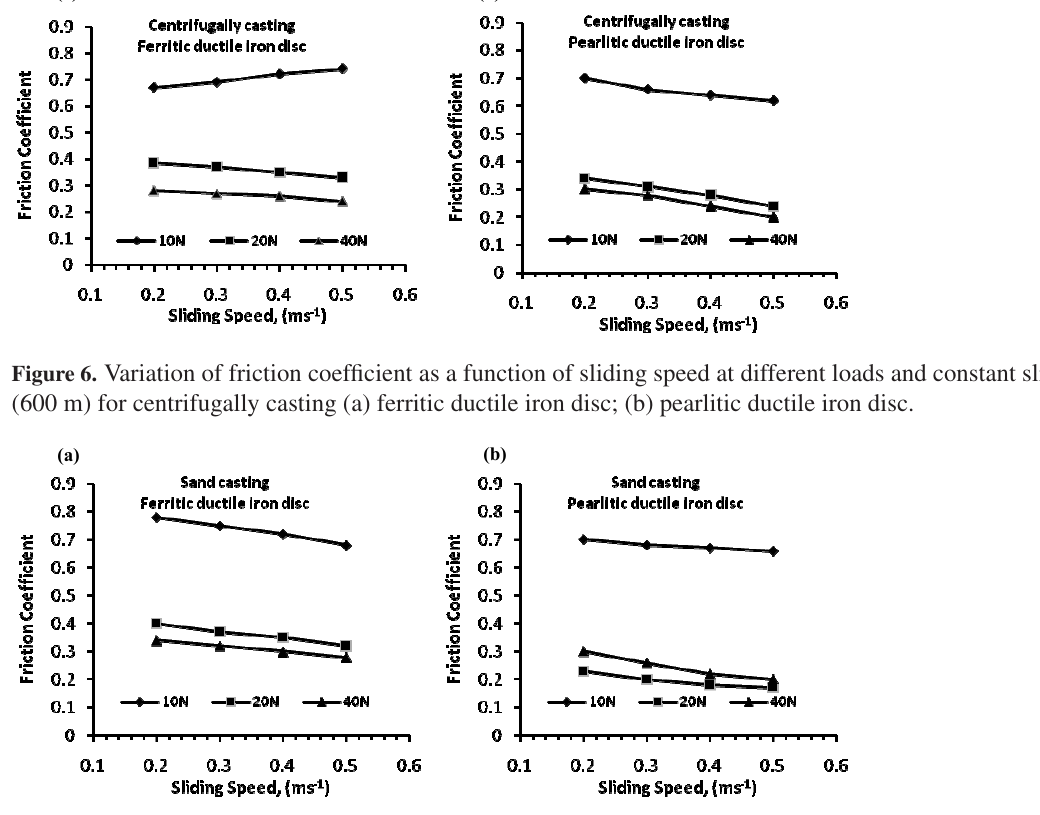
Figure 7. Variation of friction coefficient as a function of sliding speed at different loads and constant sliding distance (600 m) for sand casting (a) ferritic ductile iron disc; (b) pearlitic ductile iron